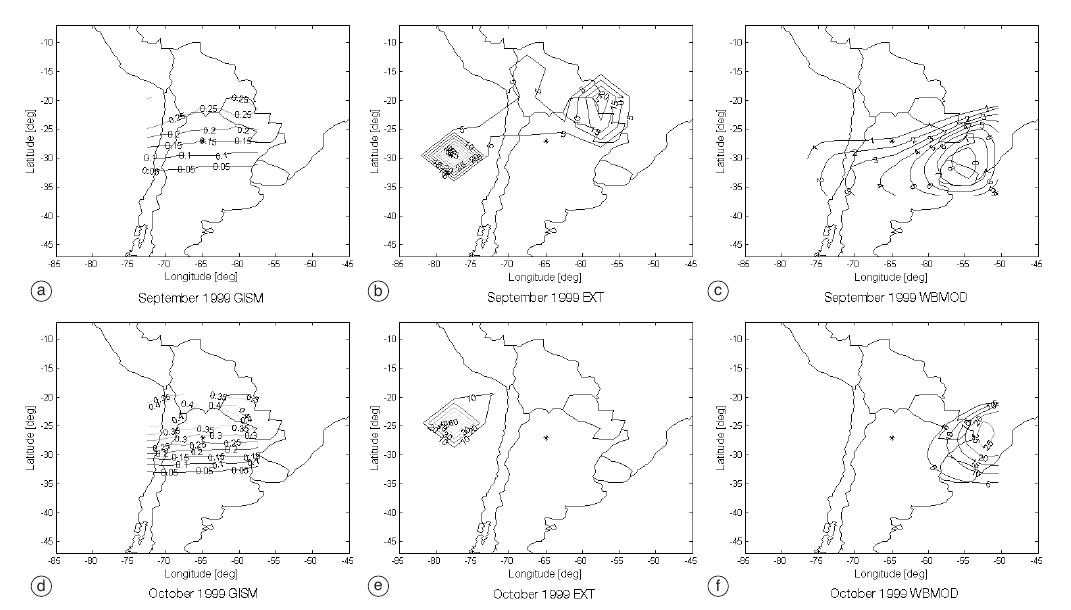
Fig. 2a-f. Percentages of occurrence of S 4 > 0.5 for experimental data and WBMOD and predicted S 4 values by GISM are shown at 20 LT (September and October 1999).